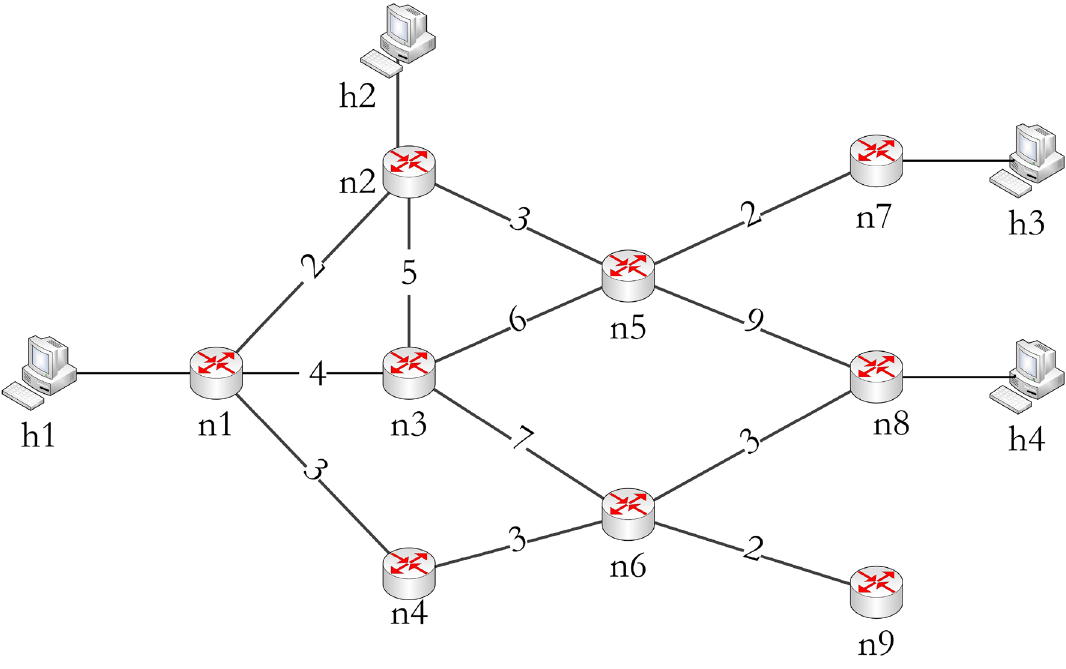
Figure 1. Experimental network